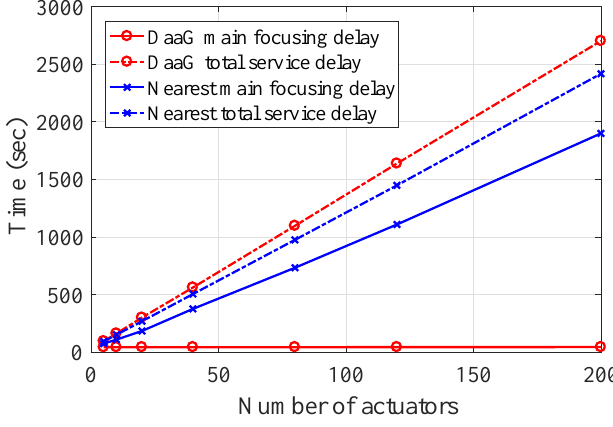
Figure 9. Delay measurement from the